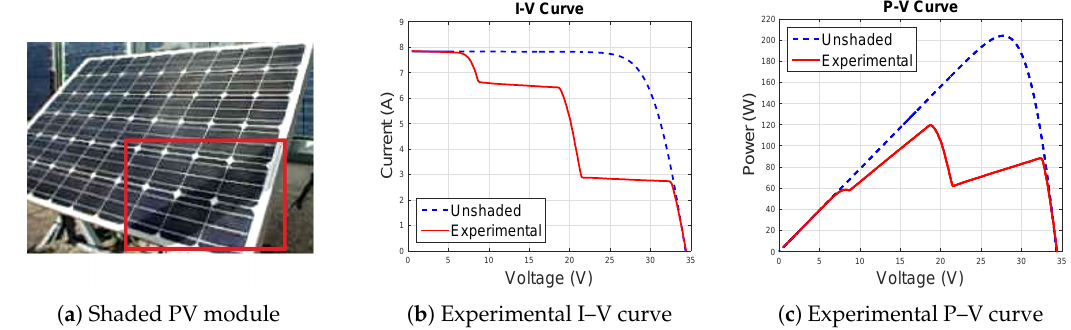
Figure 2. Photovoltaic module under partially shaded